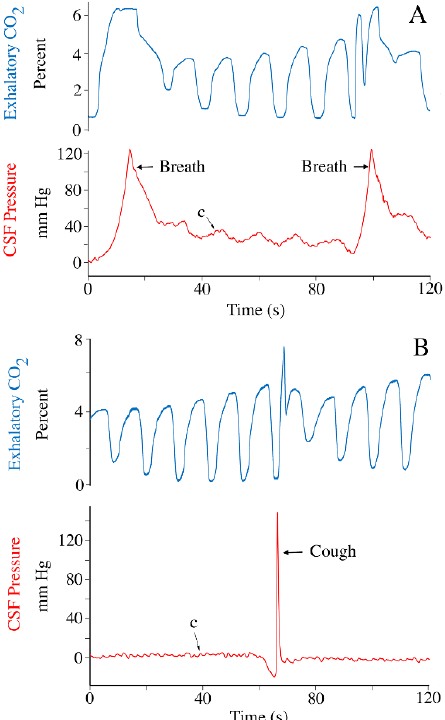
Figure 7. Records of active breathing during recovery from anesthesia. One of the alligators ( A ) took two deep breaths, while the other alligator ( B ) coughed. All of these active breaths changed both the CSF pressure (red) and the pattern of exhalatory CO 2 (blue). c—individual cardiac-related pulsation. When the animal was judged to have fully recovered from anesthesia, all leads ex- cept for the implanted pressure catheter, were removed and the animal was placed in a custom-built treadmill (which was not running). The animal was left undisturbed until it began independent sustained locomotion along the treadmill. CSF pulsations recorded during these non-locomotor periods (Figure 8A) had a mean frequency of 0.39 Hz (or 23.9 beats per minute, s.d. = 4.7) and mean amplitude of 3.8 mm Hg (s.d. = 0.19); these were not significantly different (paired t -test for frequency: t = 0.598, p = 0.572, df = 13; for amplitude: t = 0.989, p = 0.329, df = 34) from the cardiac-linked pulsations recorded while the animal was under anesthesia (Figure 8B). During this time, while not locomot- ing, the CSF pressure record and the movement of the animal’s body were suggestive of active breathing (Figure 9). Since the exhalatory CO 2 was no longer being monitored, the designation of active breathing is only provisional. During this time, there were also marked changes in baseline CSF pressure (mean 12 mm Hg, s.d. = 15.25) which seemed to be related to postural shifts and associated changes in body tone (Figure 10). The animals would extend their limbs lifting their body off the treadmill surface (lowering baseline CSF, Figure 10A) or would sprawl onto the surface of the treadmill, compressing their body cavities with their body mass (raising baseline CSF, Figure 10A). The term “body tone” is used to convey the changes in the width of the alligator’s trunk that were evident in the video record whenever the animal would switch between resting on the substrate or supporting itself on its